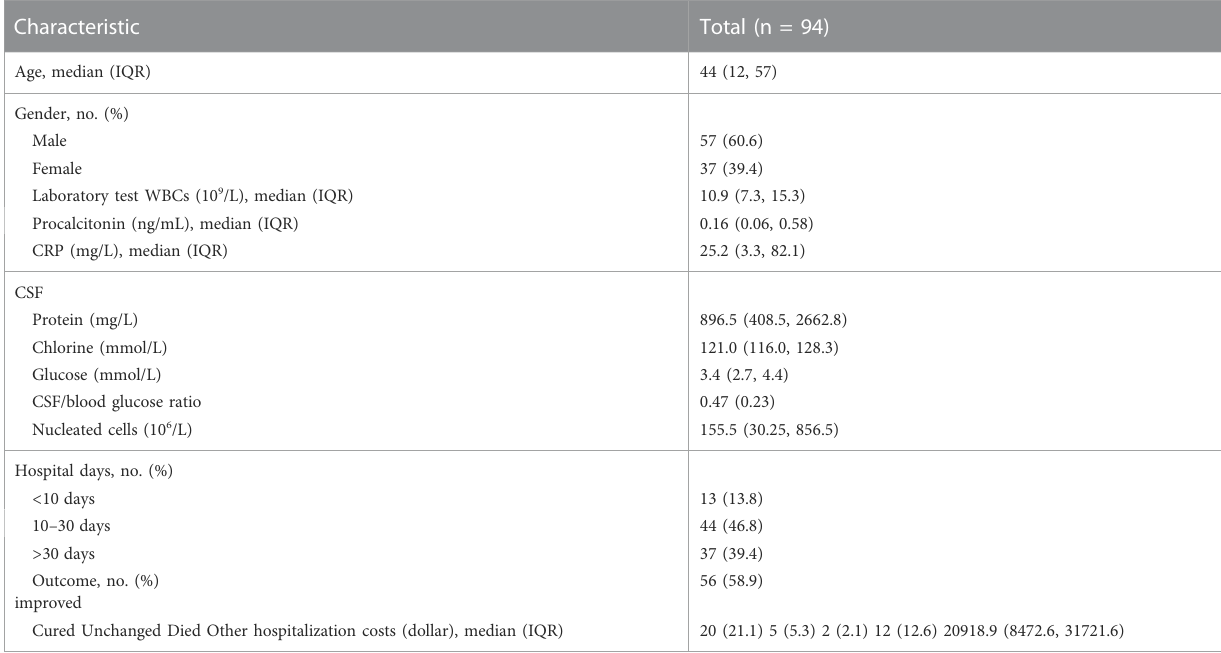
TABLE 1 Baseline characteristics of the participants. Characteristic